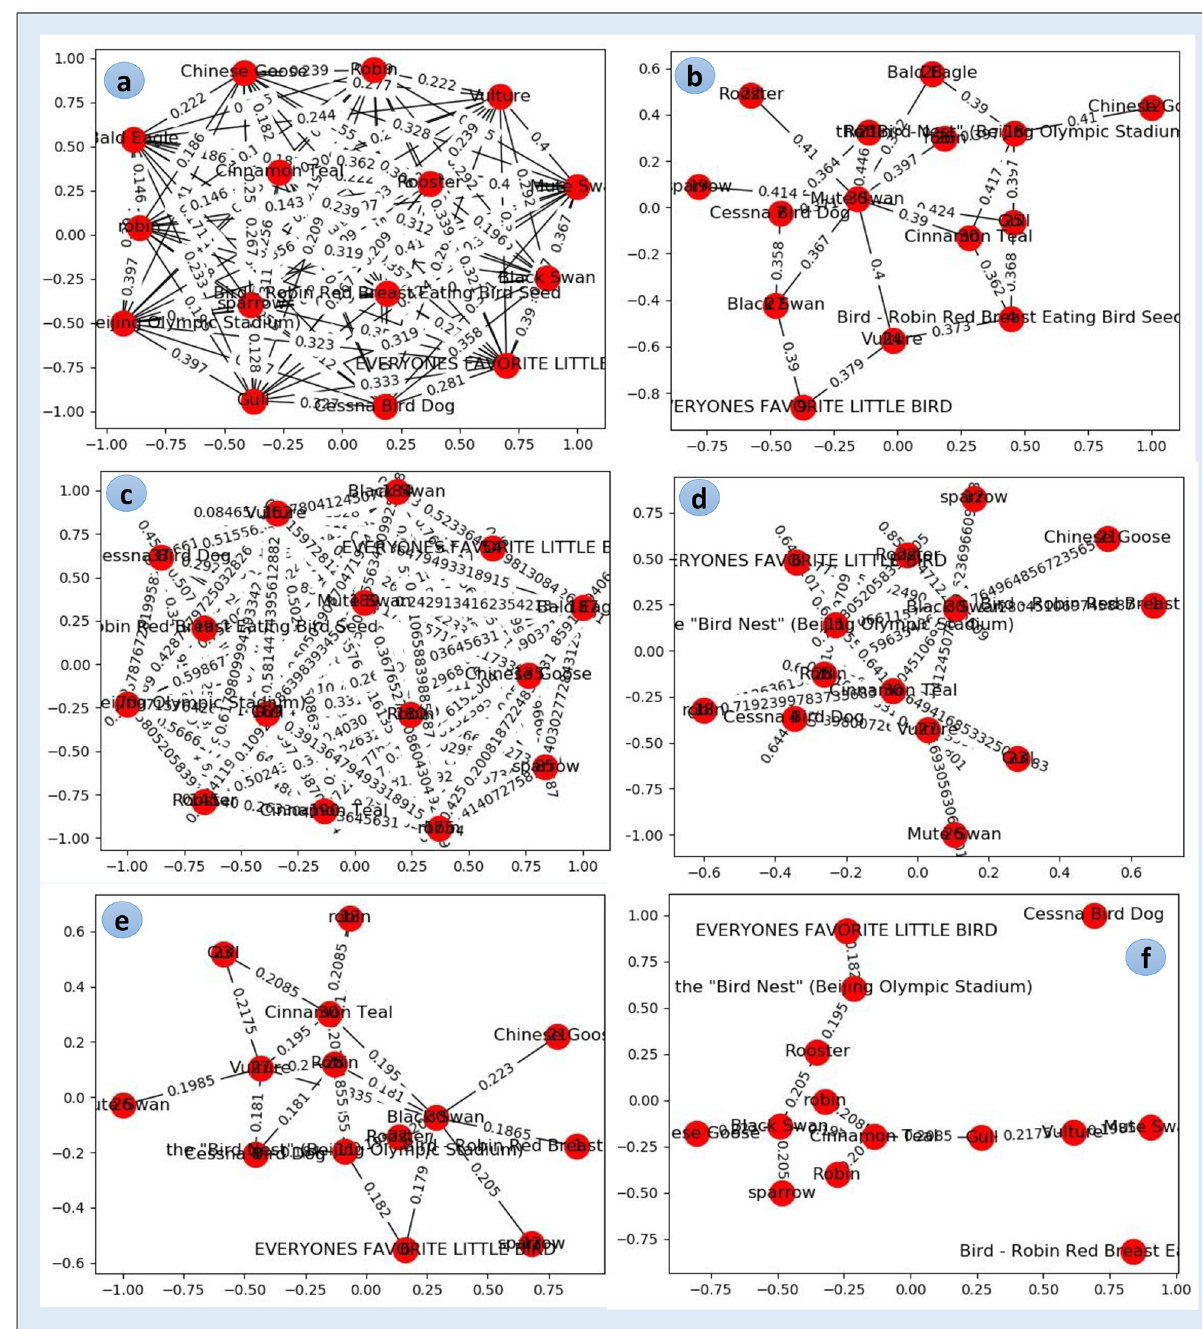
Fig 5. Cluster-graph data model construction over real image results.